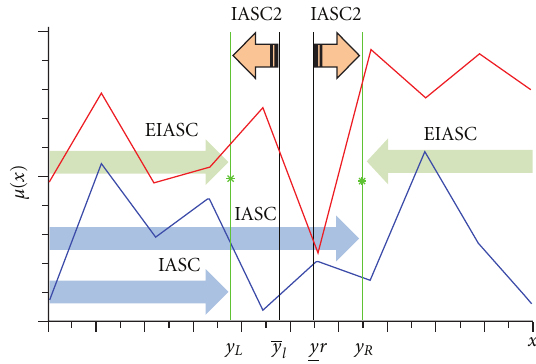
Figure 1: Uniform random FOU: 𝑓 𝑖 (red line) and 𝑓 𝑖 (blue line). The arrows indicates the computation of minimum and maximum. Orange arrows correspond to IASC2, green to EIASC and blue to